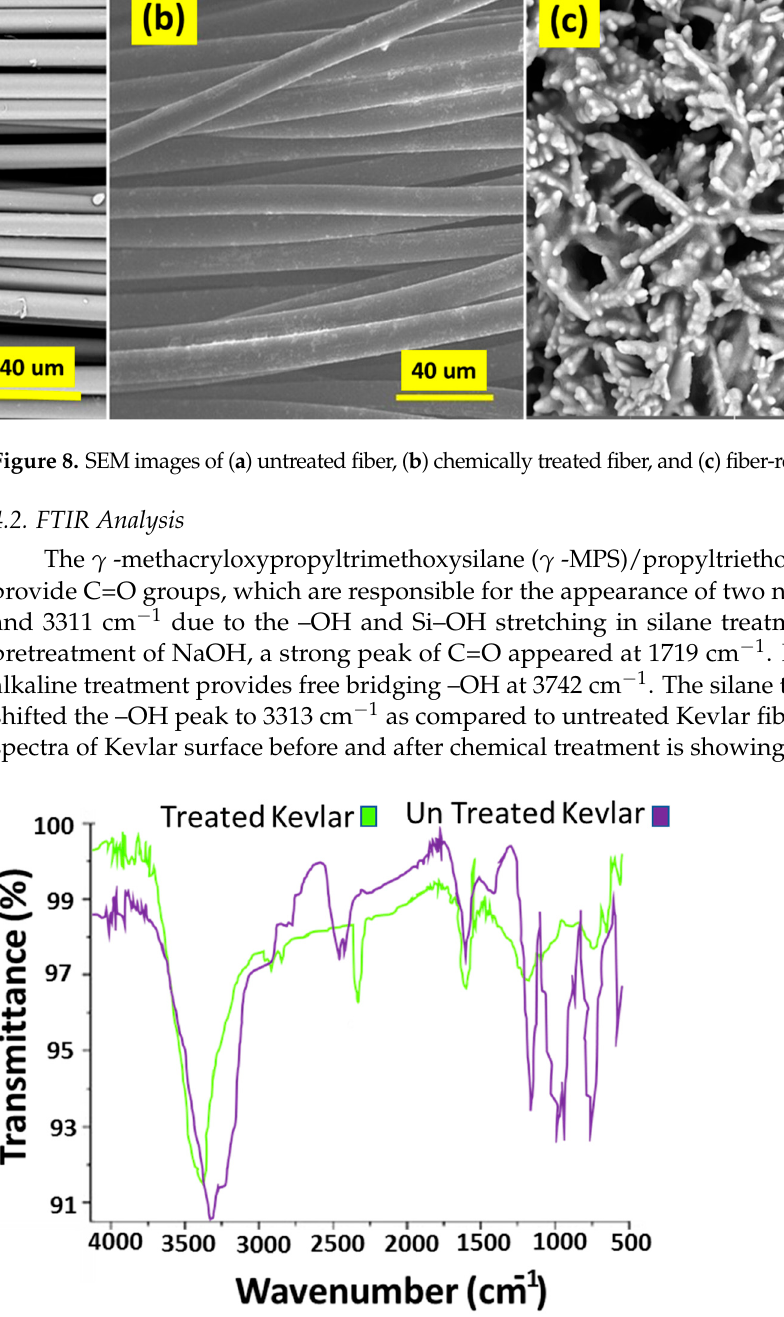
Figure 9. FTIR analysis of Kevlar surface before and after chemical treatment.